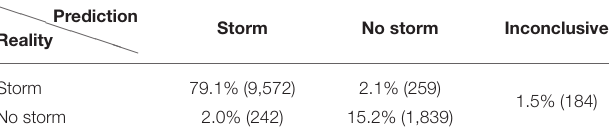
TABLE 4 | Experiment 1: FNN 1 using B y only.